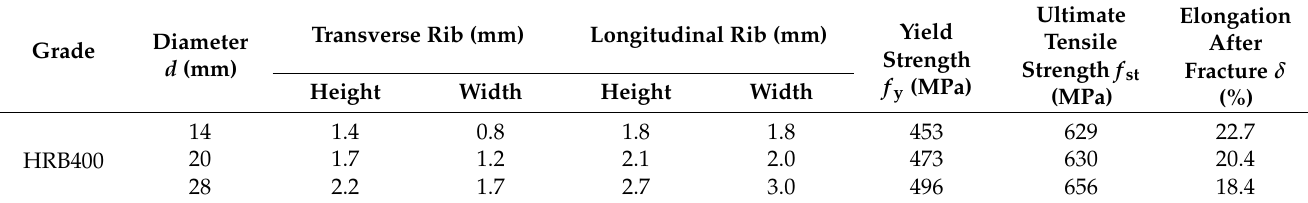
Table 1. Test results of outline dimension and mechanical properties of ribbed steel bars.